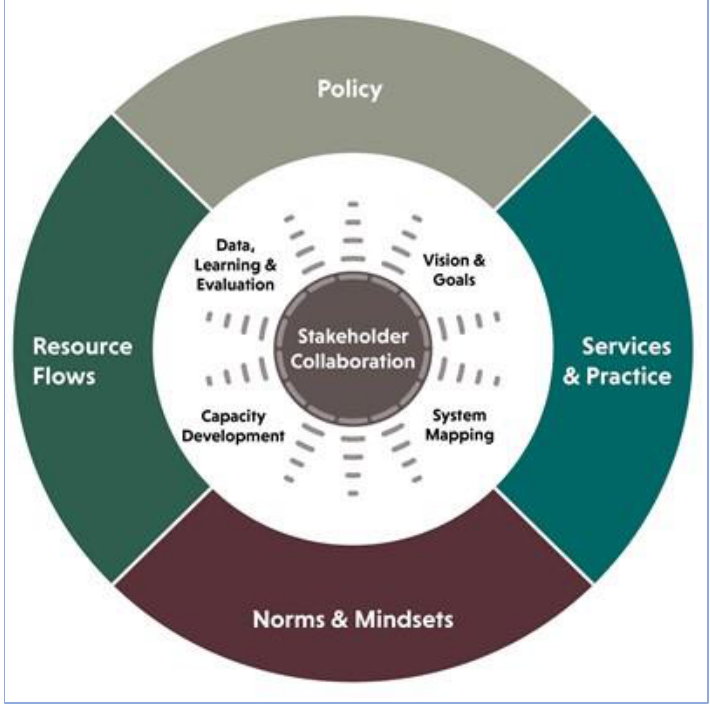
Figure 1. Youth Systems Framework by the Youth Systems